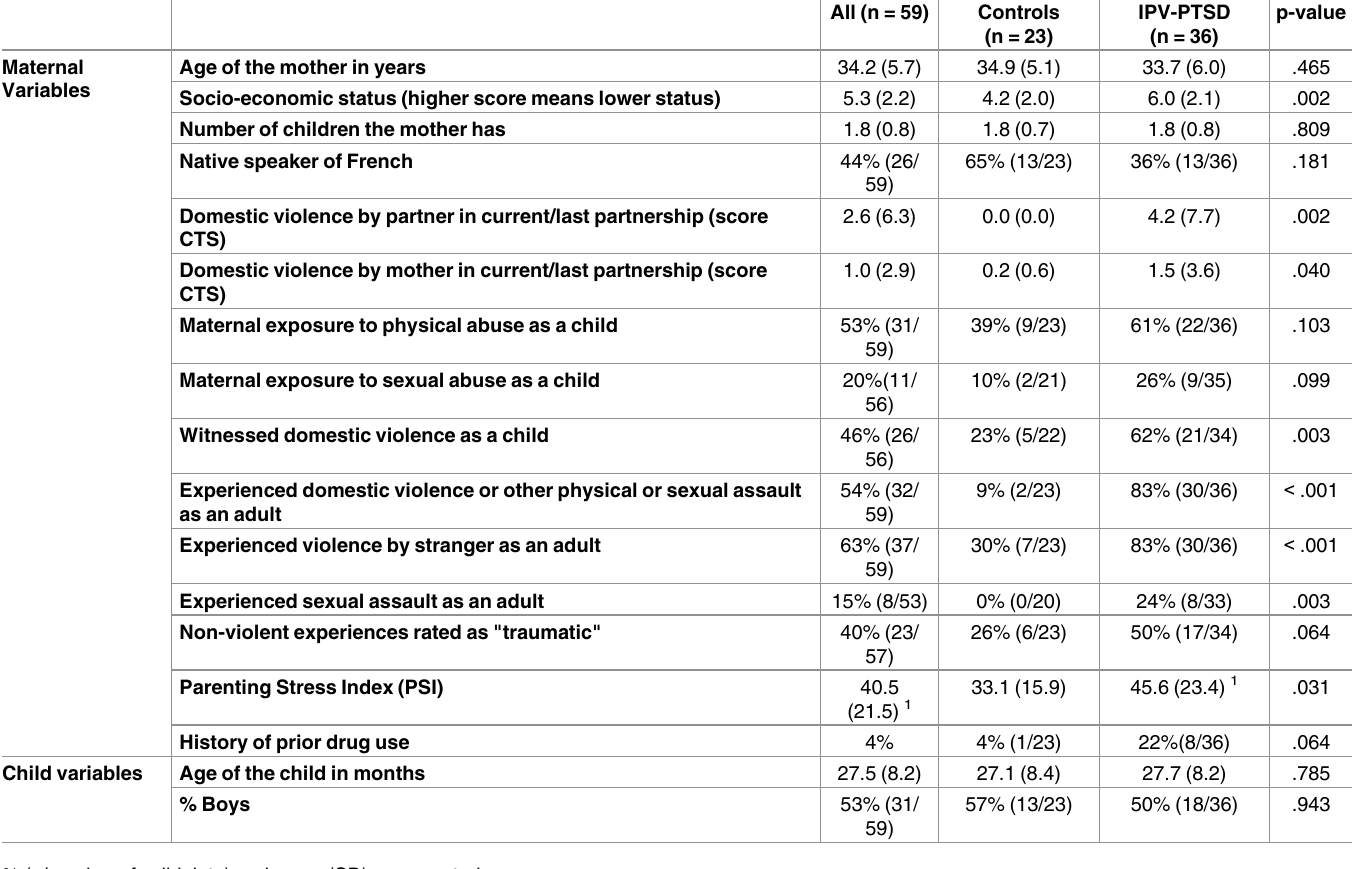
Table 1. Characteristics of IPV-PTSD and non-PTSD mothers and